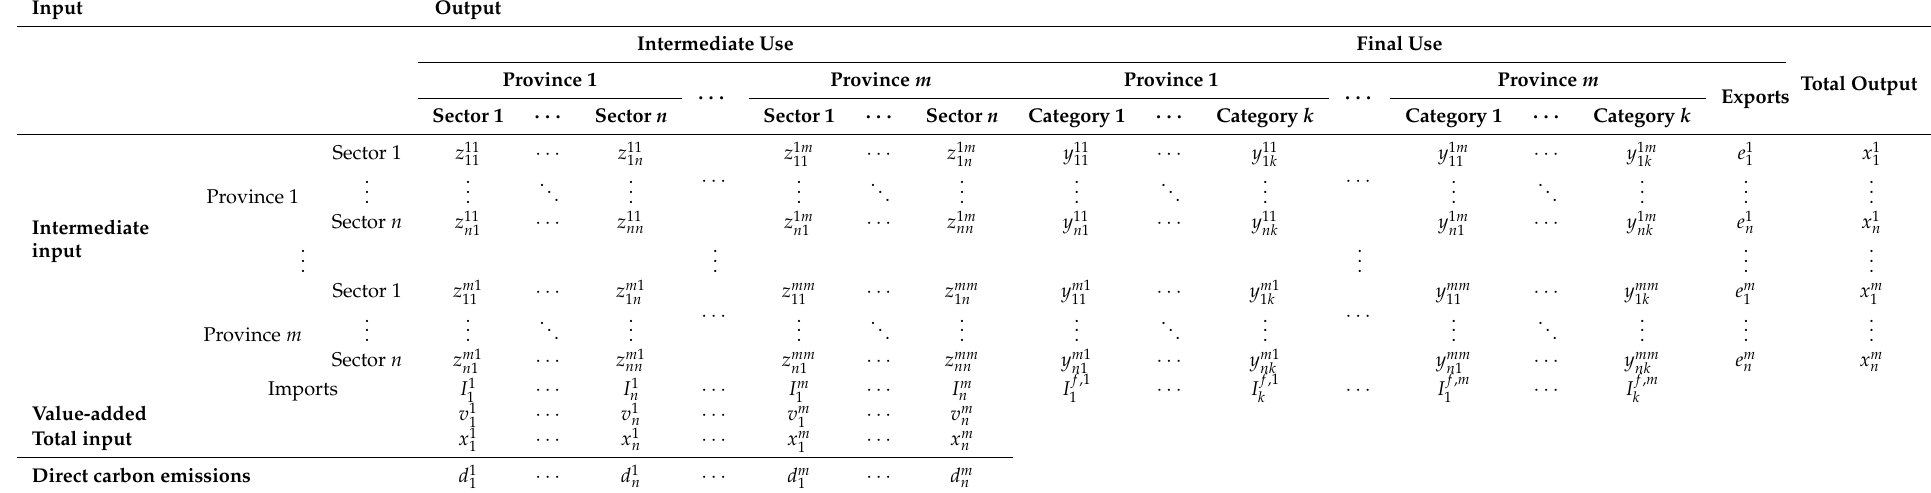
Table 1. Chinese MRIO